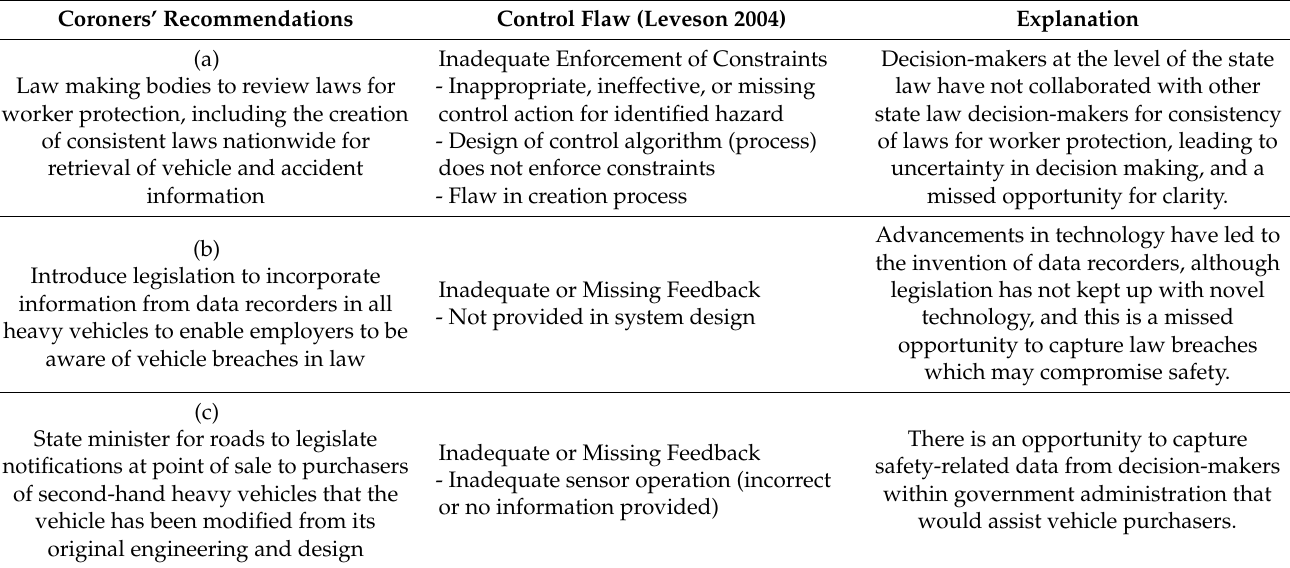
Table 6. Coroners’ Recommendations Mapped at STAMP Level 1—Government and Legislature and Assigned to a Control Flaw ( n = 3).